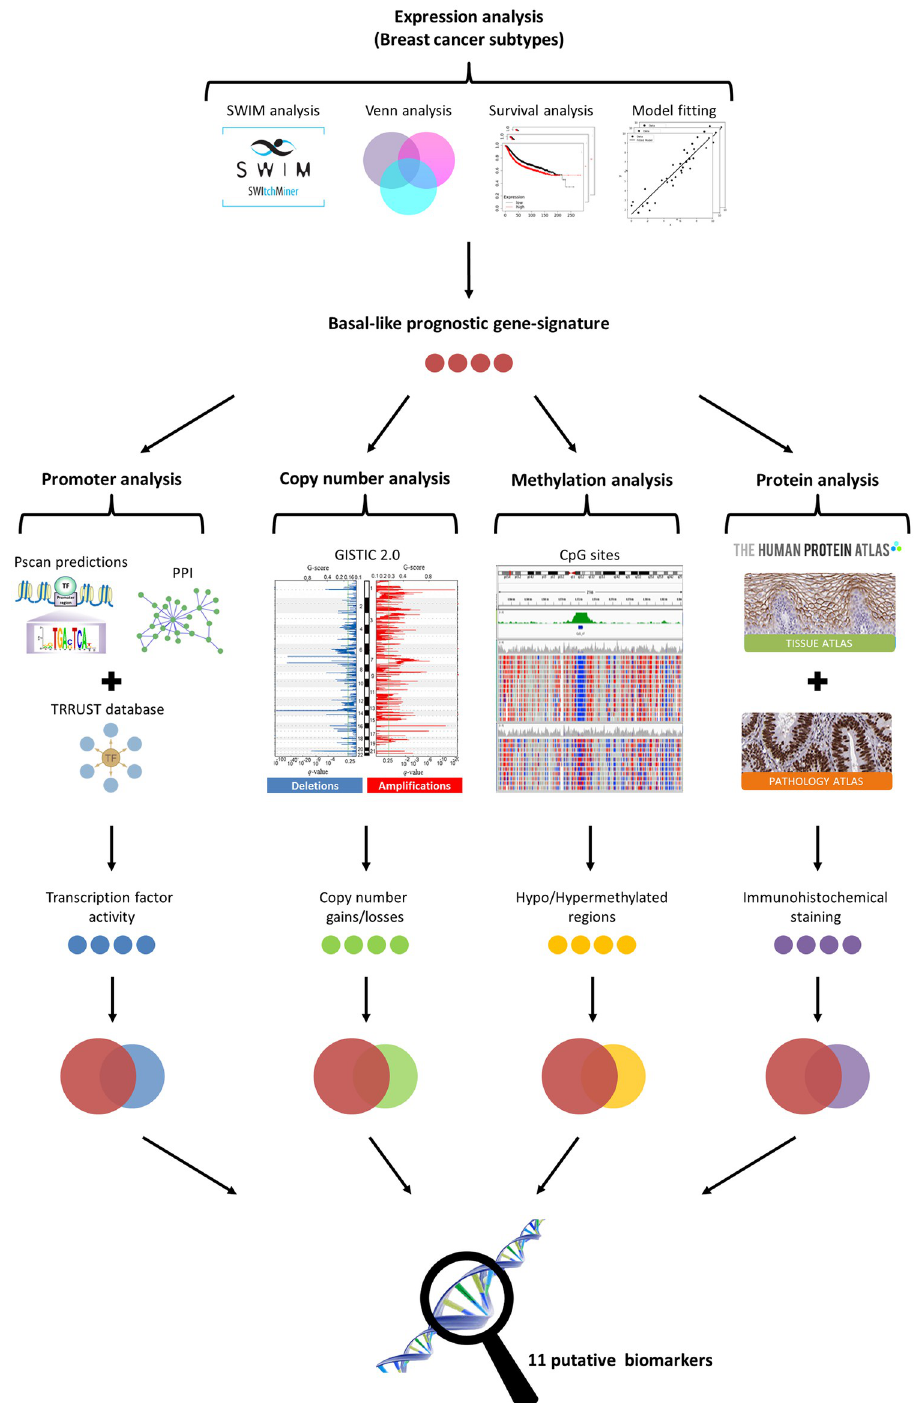
Fig 1. Study design. The figure depicts the schematic of the methodology applied in this study.